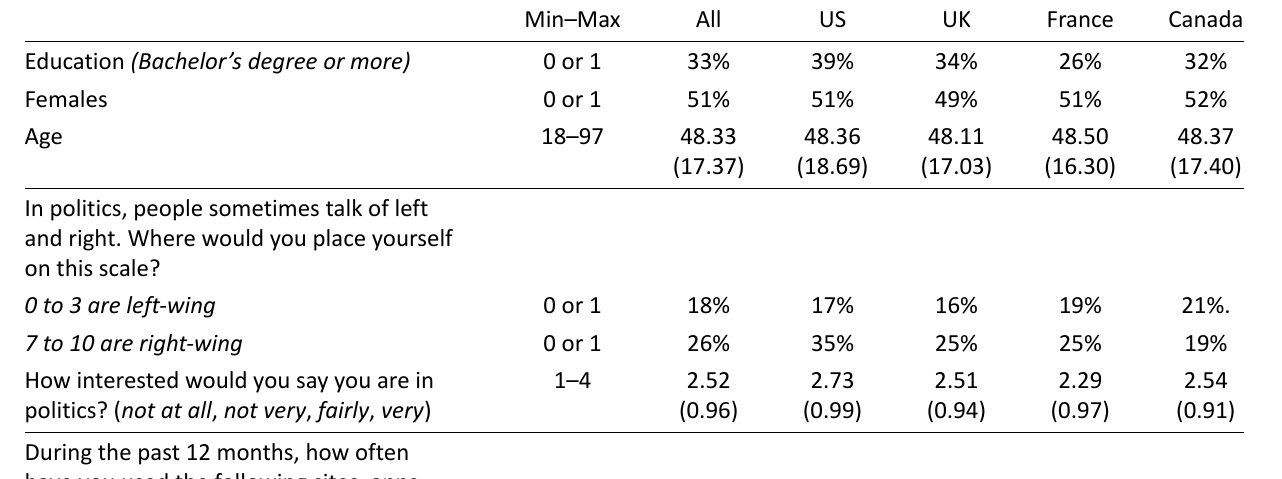
Table 1. Descriptive statistics by